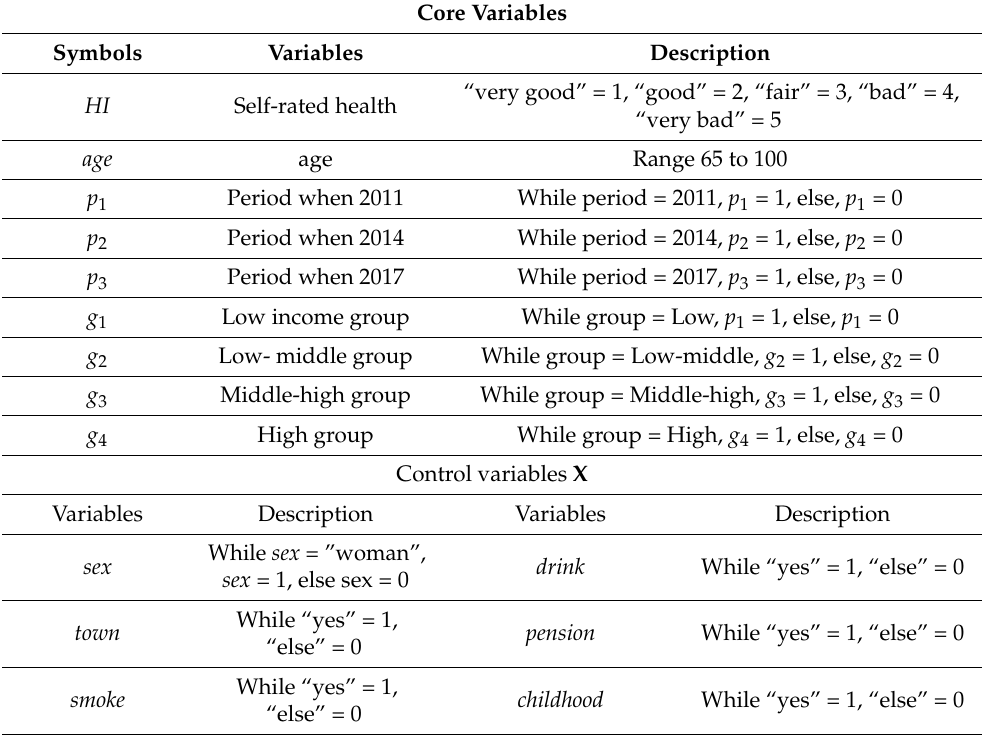
Table 2. Variable symbols and